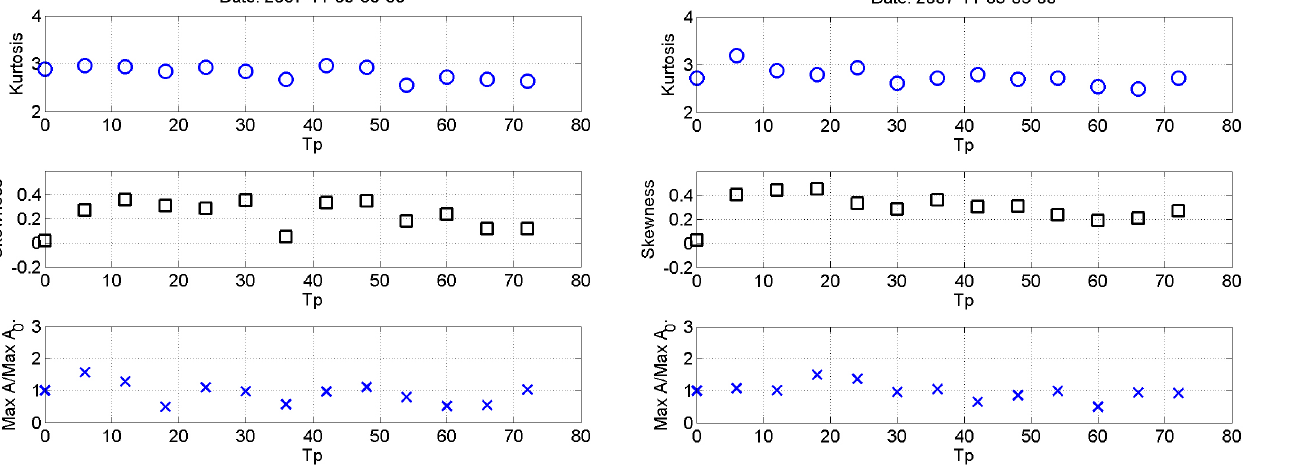
Figure 9. Temporal evolution of skewness, kurtosis and A max / A 0 ( A 0 denotes the initial amplitude used in the simulations while A max is the maximum amplitude (crest)), 9 November 2007,